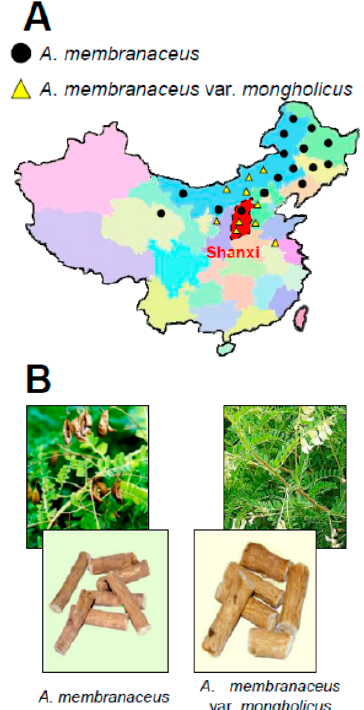
Figure 1. Sources of Astragali Radix (AR) and plant morphology. ( A ) AR produce source is widely present in the mainland of China. Astragalus membranaceus is mainly produced in the northwest and west of China (black dots). A. membranaceus var. mongholicus is greatly produced in the west of China, (yellow triangles). AR collected from Shanxi, China, highlighted in red, is believed to be “Di Dao” material. ( B ) Authentic plants of A. membranaceus (left) and A. membranaceus var. mongholicus (right).